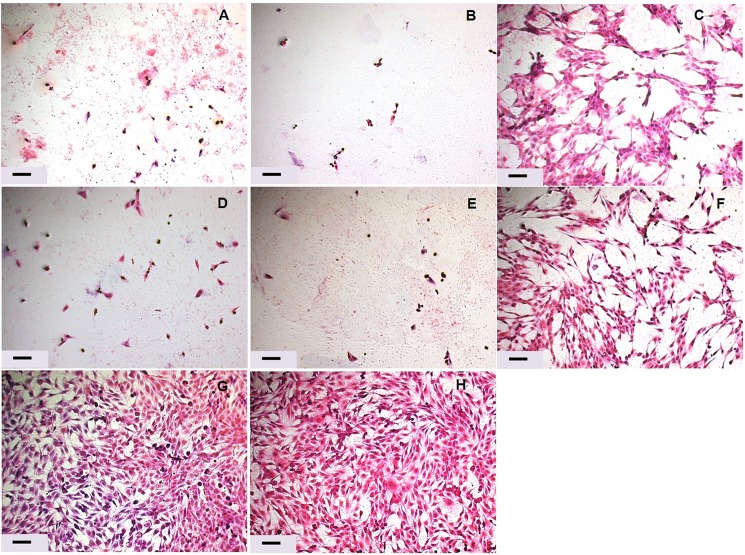
Step 2.Representative H+E images of the 24 h varnishes’ treatments. (A) 4.00% TiF4, (B) 3.10% TiF4, (C) 1.50% TiF4, (D) 5.42% NaF, (E) 4.20% NaF, (F) 2.10% NaF, (G) Control, (H) Placebo. 4.00% TiF4 and 5.42% NaF (2.45% F); 3.10% TiF4 and 4.20% NaF (1.90% F); 1.50% TiF4 and 2.10% NaF (0.95% F). Scale bar, 100 μm.